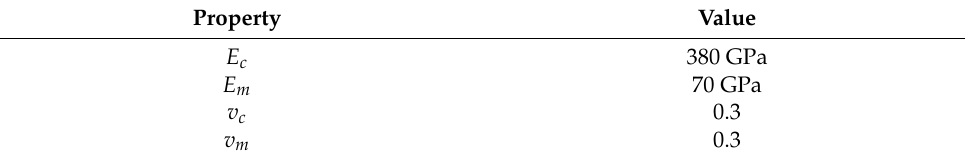
Table 3. Material properties of the system.